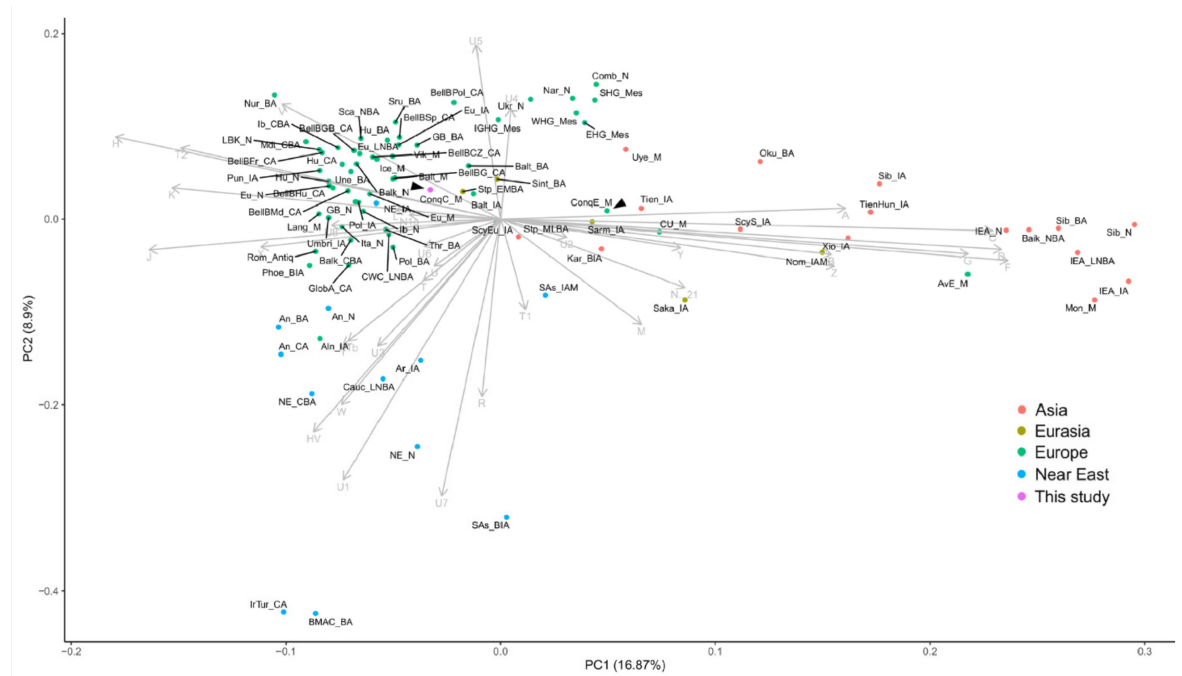
Figure 4. The principal component analysis (PCA) plot of the major mtDNA haplogroup distribution (distinguishing Hgs A, B, C, D, F, G, H, HV, I, J, K, L, M, N, N1a, N1b, R, T, T1, T2, U, U1, U2, U3, U4, U5, U6, U7, U8, V, W, X, Y and Z) of 88 Eurasian populations. The abbreviations of the population names are given in Table S4b. Color shadings denote geographic regions as indicated. ConqC and ConqE are highlighted with arrowheads. PC1 separates European populations to the left and Asian populations to the right side. PC2 separates Anatolian–Caucasus groups to the bottom and hunter–gatherers to the